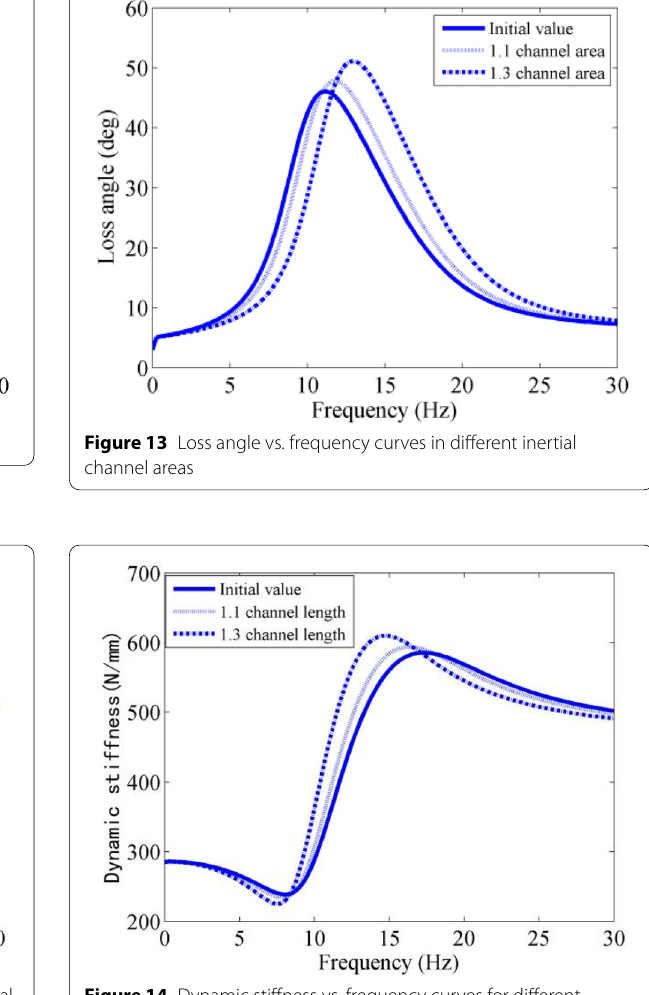
Figure 14 Dynamic stiffness vs. frequency curves for different inertial channel